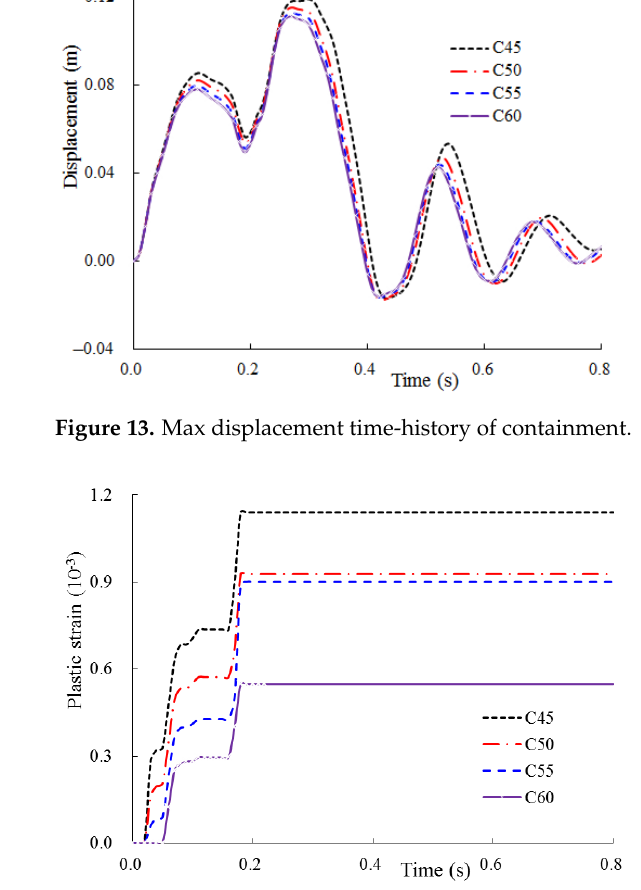
Figure 14. Max plastic strain time-history of concrete.